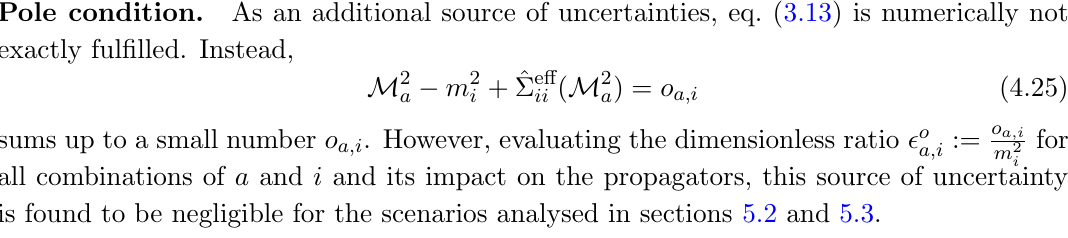
narrow width compared to the mass, but also by the smallness of the higher derivatives at the pole. We con(cid:12)rmed numerically that already the second derivatives are suppressed by several orders compared to the (cid:12)rst